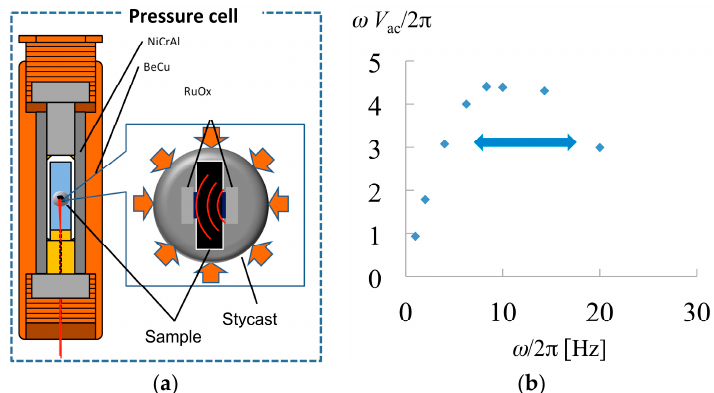
Figure 3. ( a ) Schematic of the ac calorimetry system in the hybrid pressure cell of CuBe and NiCrAl. Sample part consists of a single crystal sample and two chip sensors working as a thermometer and a heater; ( b ) a typical curve of the frequency dependence of the ac amplitude voltage to evaluate the measurement validity. In the plateau region, which is marked by the arrow, the oscillation frequency satisfies the appropriate conditions for the measurements.